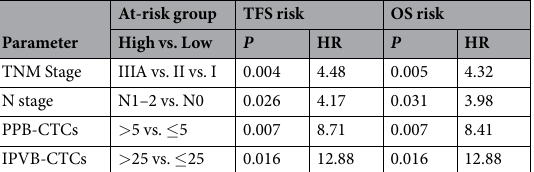
Table 3. Univariate Cox regression analysis for prediction of tumor-free survival and overall-survival * . * Abbreviations: TFS: tumor-free survival and OS: overall-survival. HR: hazard ratio; PPB-CTCs: peripheral blood circulating tumor cells; IPVB-CTCs: pulmonary venous blood circulating tumor cells. Using the PPB specimens, results showed that the TFS, Cox proportional hazards regression HR, 8.71; P = 0.007; the OS, Cox proportional hazards regression HR, 8.71; P = 0.007. Using the IPVB specimens, results showed that the TFS, Cox proportional hazards regression HR, 12.88; P = 0.0162, whereas the OS, Cox proportional hazards regression HR, 12.88; P =